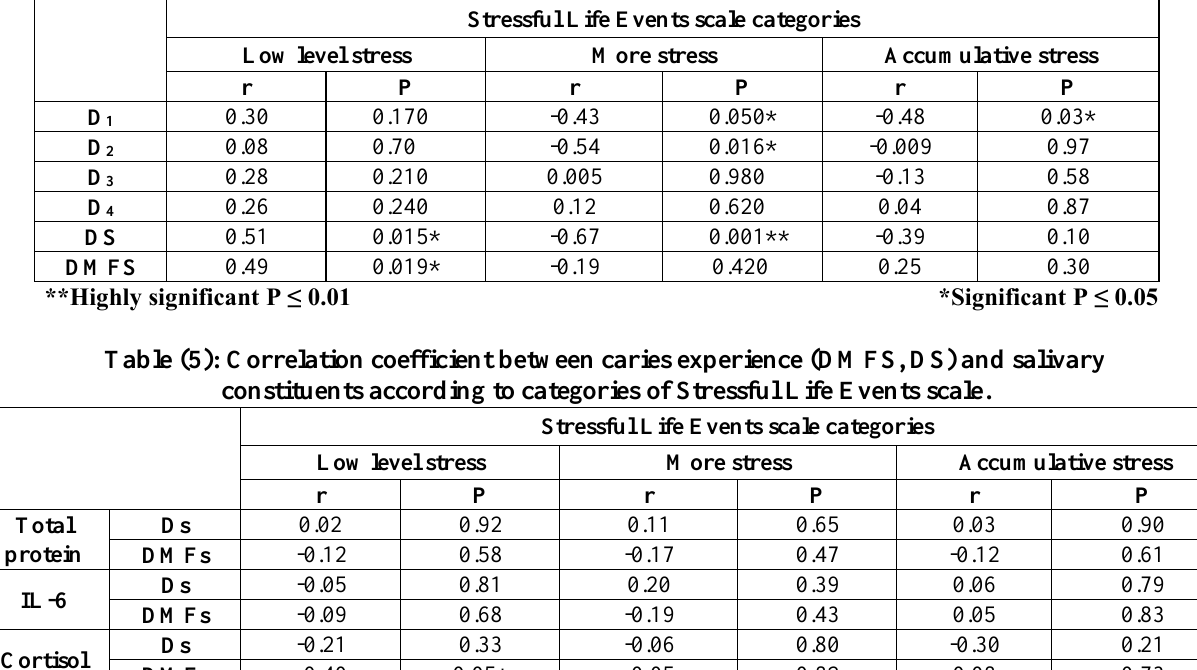
Table (4): Correlation coefficient of salivary flow rate with caries experience (DMFS and DS) and grades of lesion severity according to categories of Stressful Life Events scale .